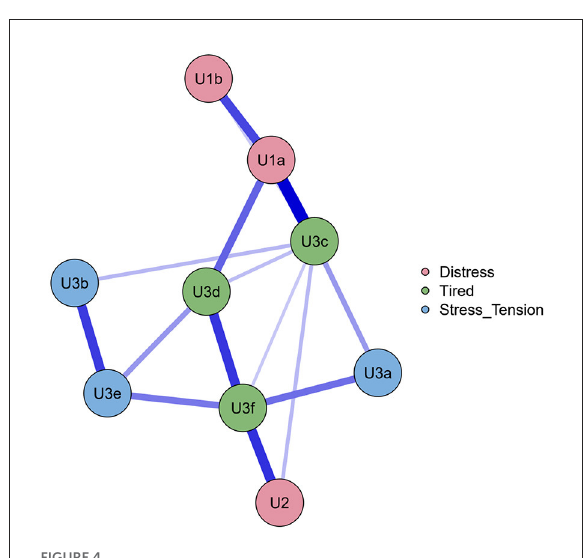
FIGURE4 Regularized networks of the anxiety items colored by facets (before collapsing). sleepy and tired, worthlessness), and four ADHD (intrusive, inattentive, disorganized, hyperactive) variables (Figure 5). Figure 6 assesses the robustness of our findings. The charts indicate that increasing the hyperparameter over 0.15